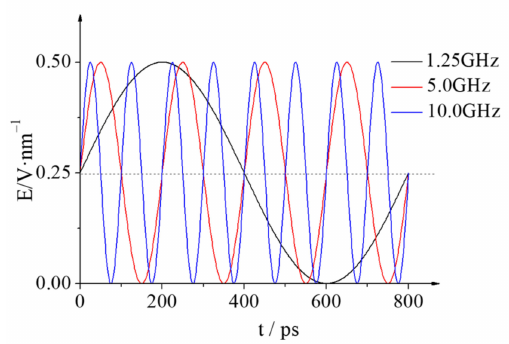
Figure 2. Time evolution of the electric field strength E when the electrical frequencies is 1.25, 5.0 and 10.0 GHz (take E = 0.50 V/nm for